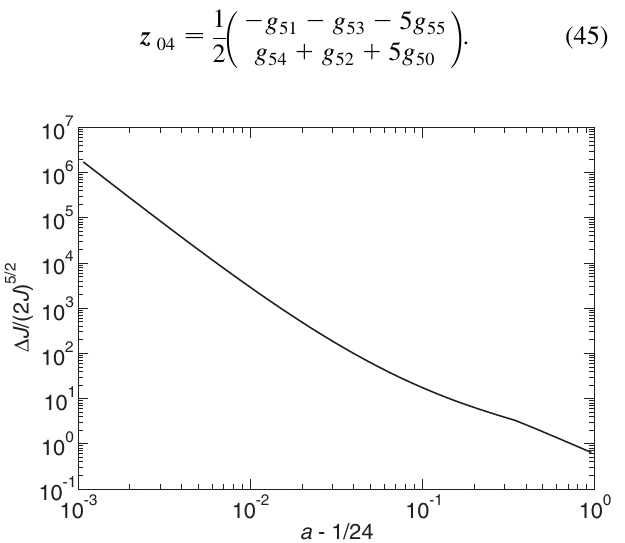
FIG. 8. Distortion of the ellipse, allowing the center and ellipse shape to change with J , minimized over b and A .